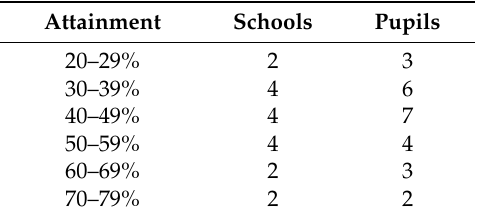
Table 2. Attainment level of schools of pupil interviewees (percentage of pupils attaining 3+ level 6 awards in 2014/15).